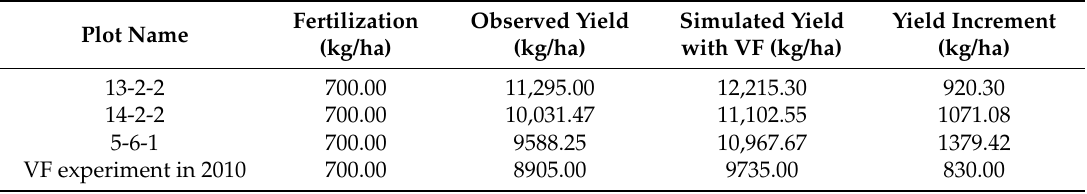
Table 11. The results of VF